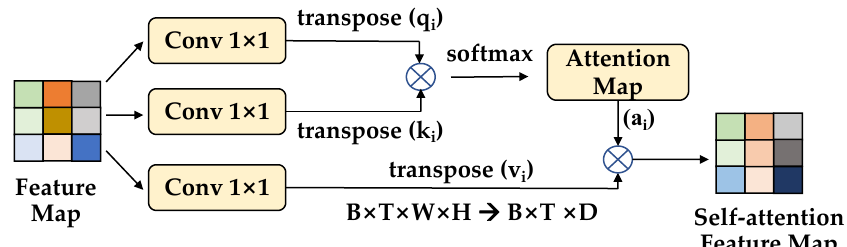
Figure 3. The structure of the self-attention